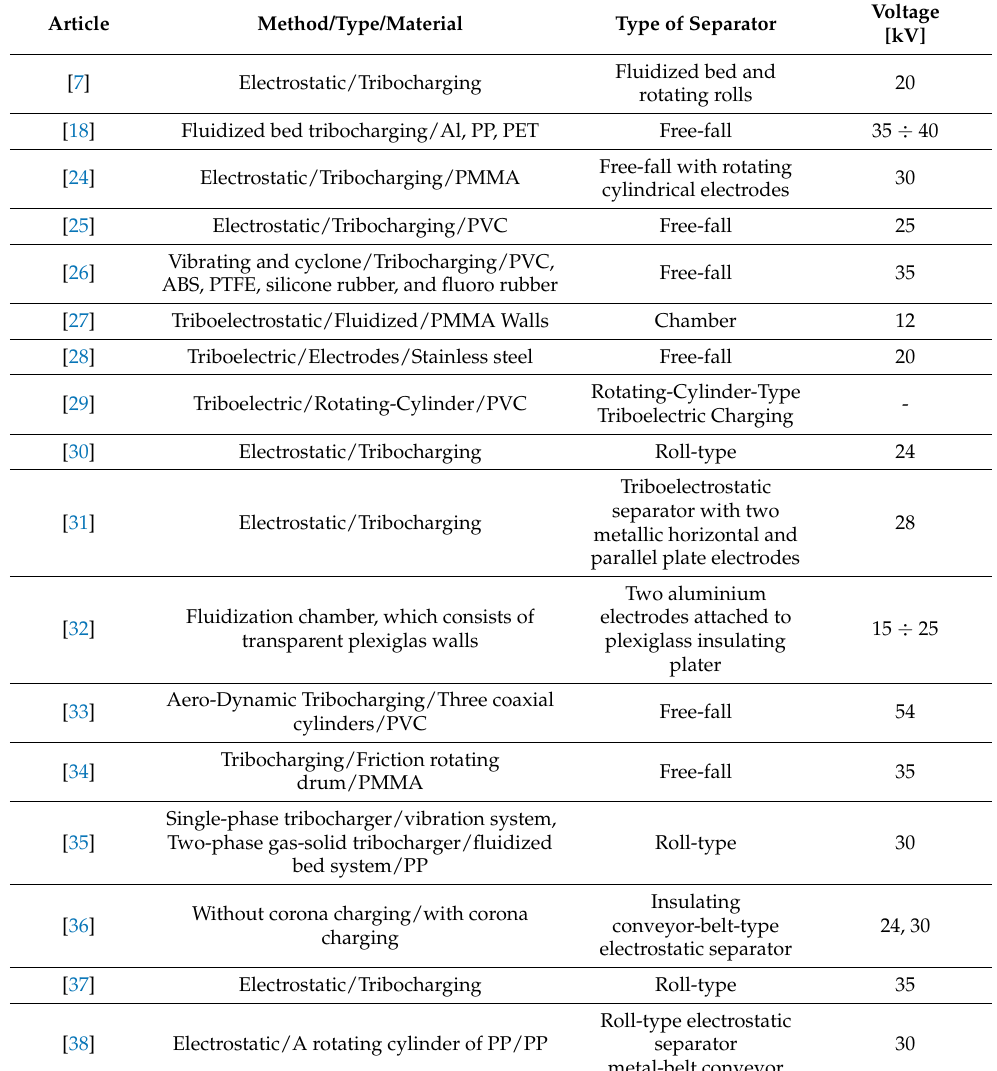
Table 2. Summary of separator types, method of charging particles and operation voltage on the basis of a literature